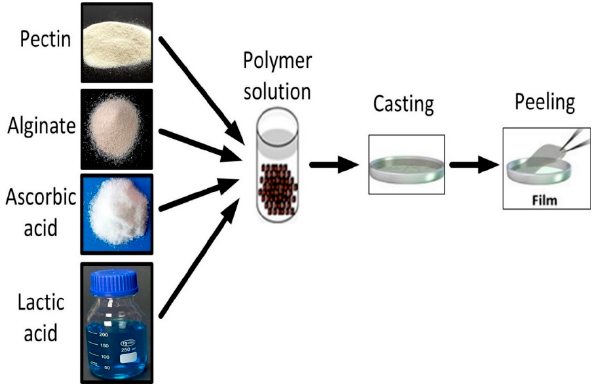
Figure 1. Schematic diagram explaining preparation of functionalized pectin–alginate films by solution casting method.